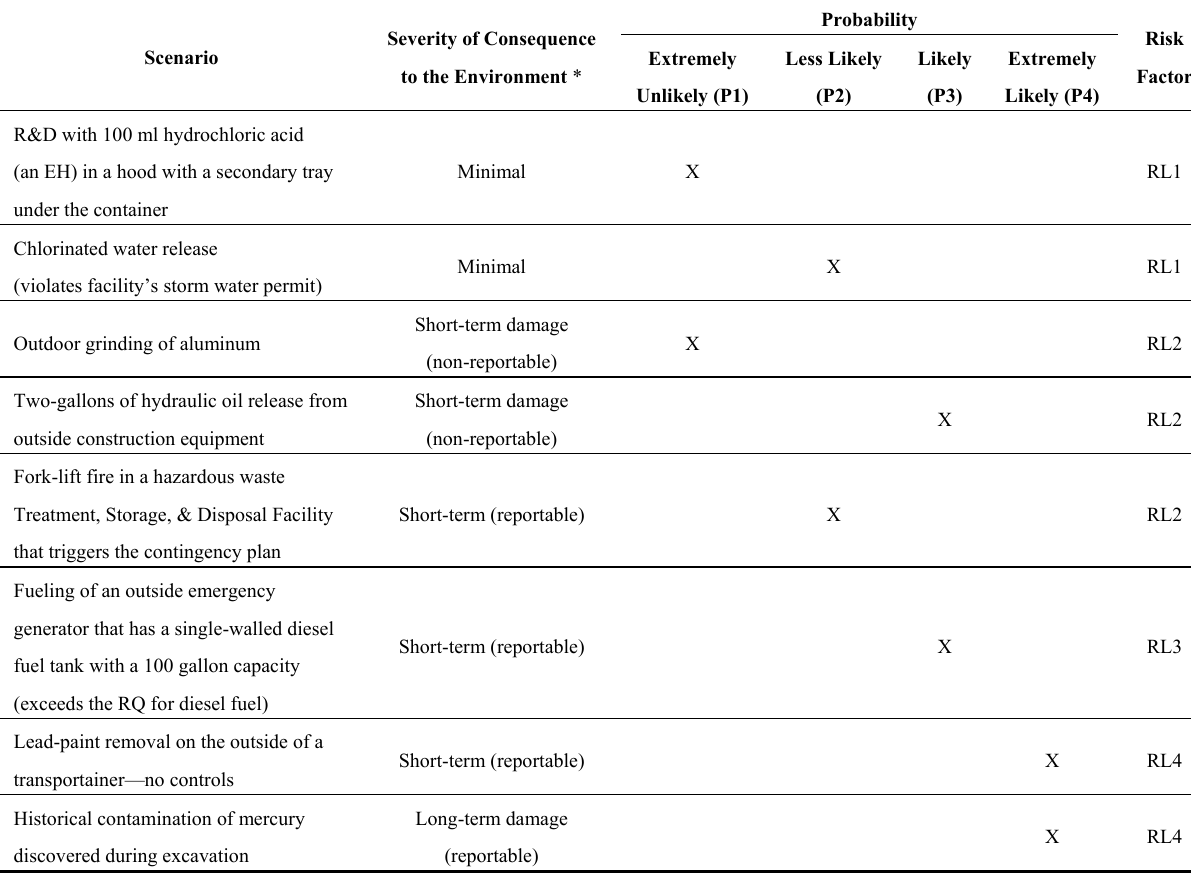
Table 3. Scenario examples vetted by